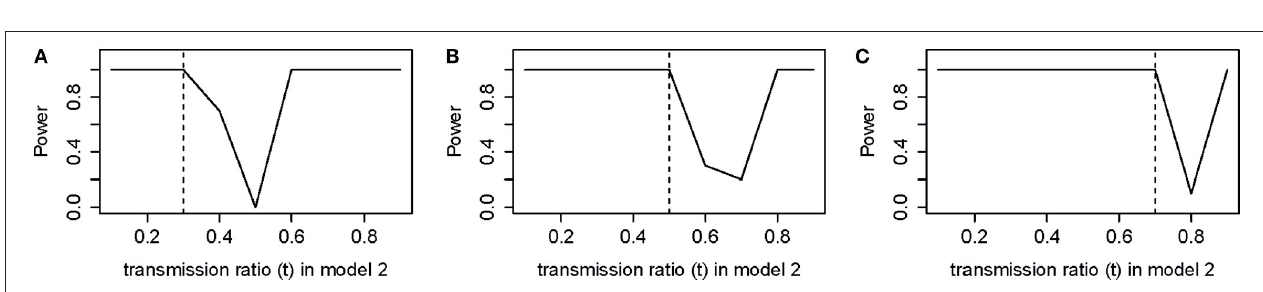
Frontiers in Genetics |